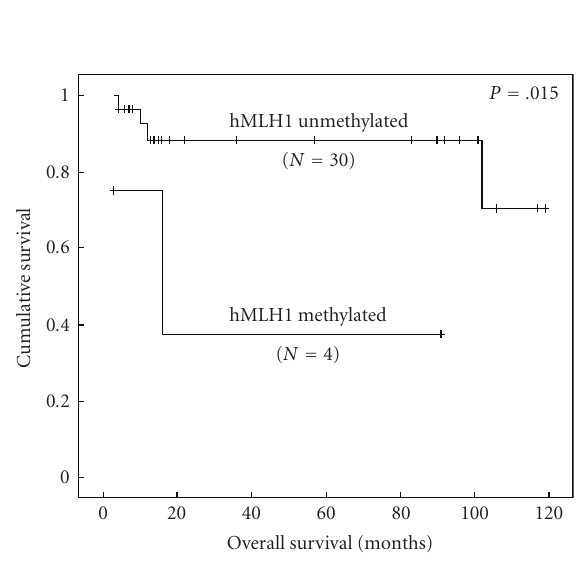
Figure 3: Kaplan-Meier survival curve correlating overall survival with hMLH1 methylated and unmethylated